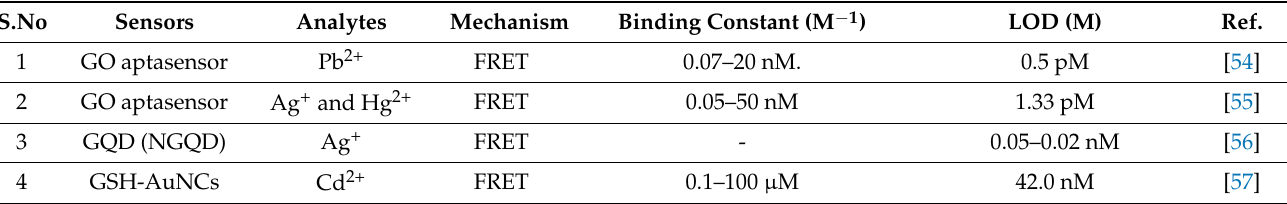
Table 1. Comparison of properties based on different analytes.